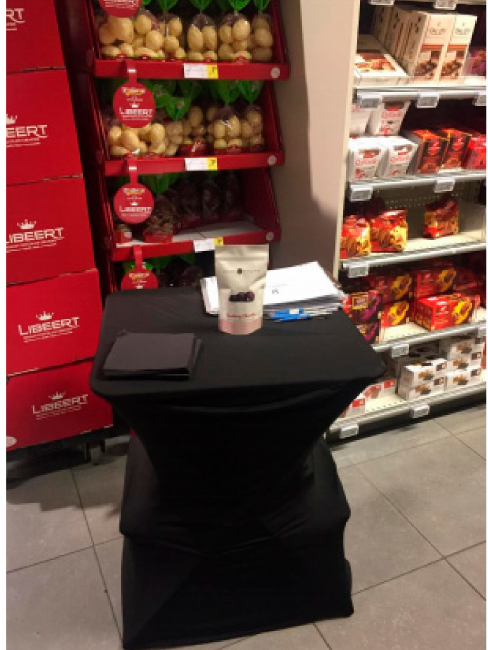
Figure 1. Sampling booth in front of a chocolate assortment in store, displaying one package prototype.